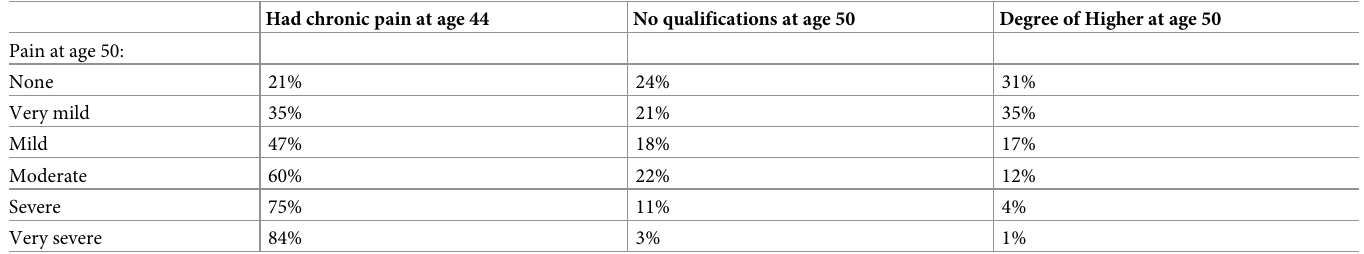
Table 7. Pain in NCDS at Age 50 (cell